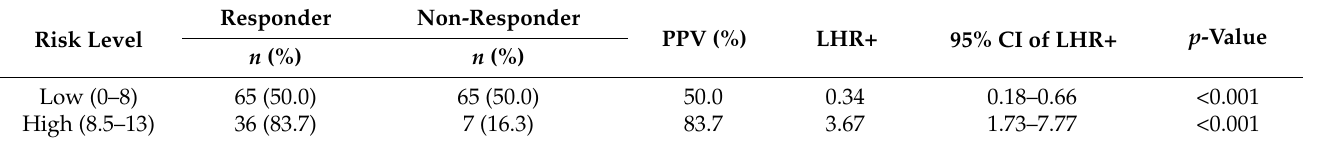
Table 4. Distribution of risk level for responder, PPV, likelihood ratio of positive (LHR+), and 95%